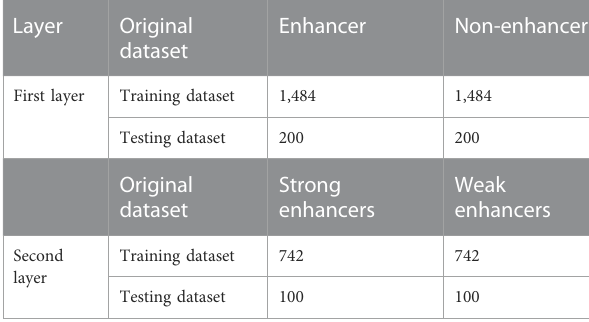
TABLE 1 Speci fi cs of the benchmark